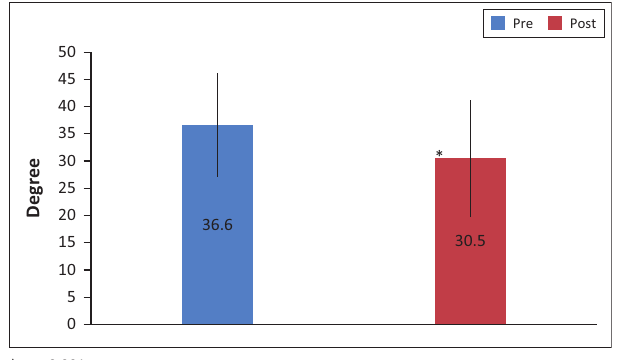
FIGURE 3: Mean knee extension range of motion (in degrees) ± standard deviation pre- and post-intervention in the group that received passive